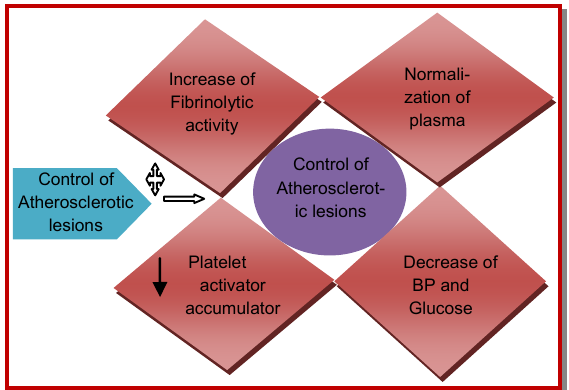
Figure 1: Allinase enzyme from garlic helps in enhancement of fibrinolytic activity, normalization of plasma cells, decrease platelet activator accumulator and decrease of blood pressure and